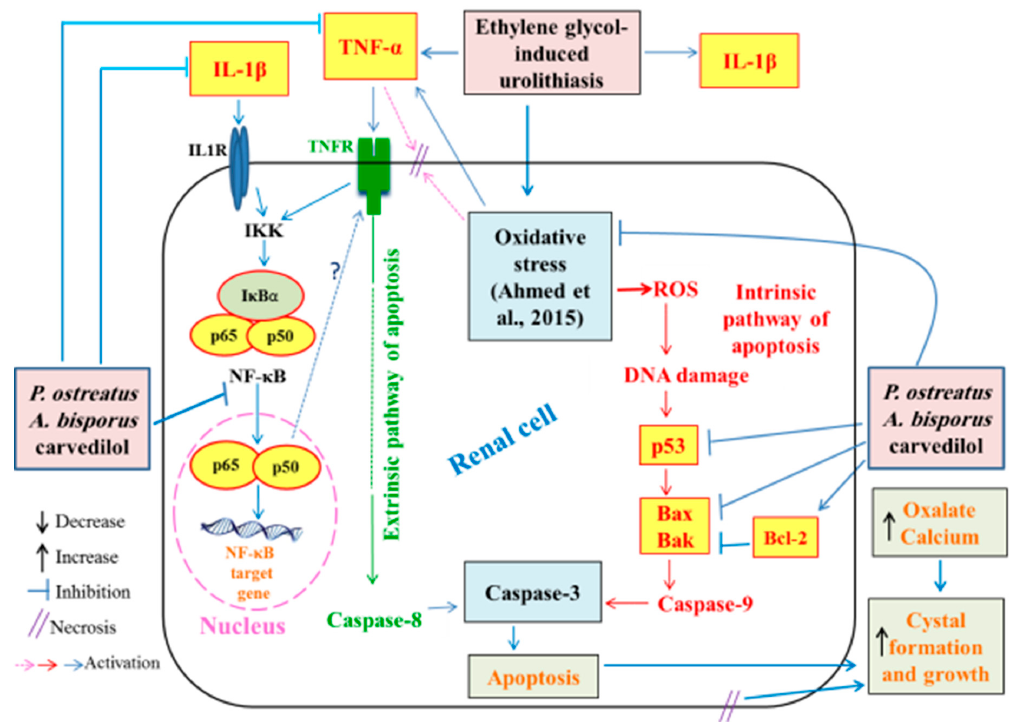
Figure 25. Schematic diagram showing the effects of P. ostreatus and A. bisporus extracts and carvedilol on NF- κ B, p53 and Bcl-2 to suppress inflammation and apoptosis together with the effects on oxidative stress.